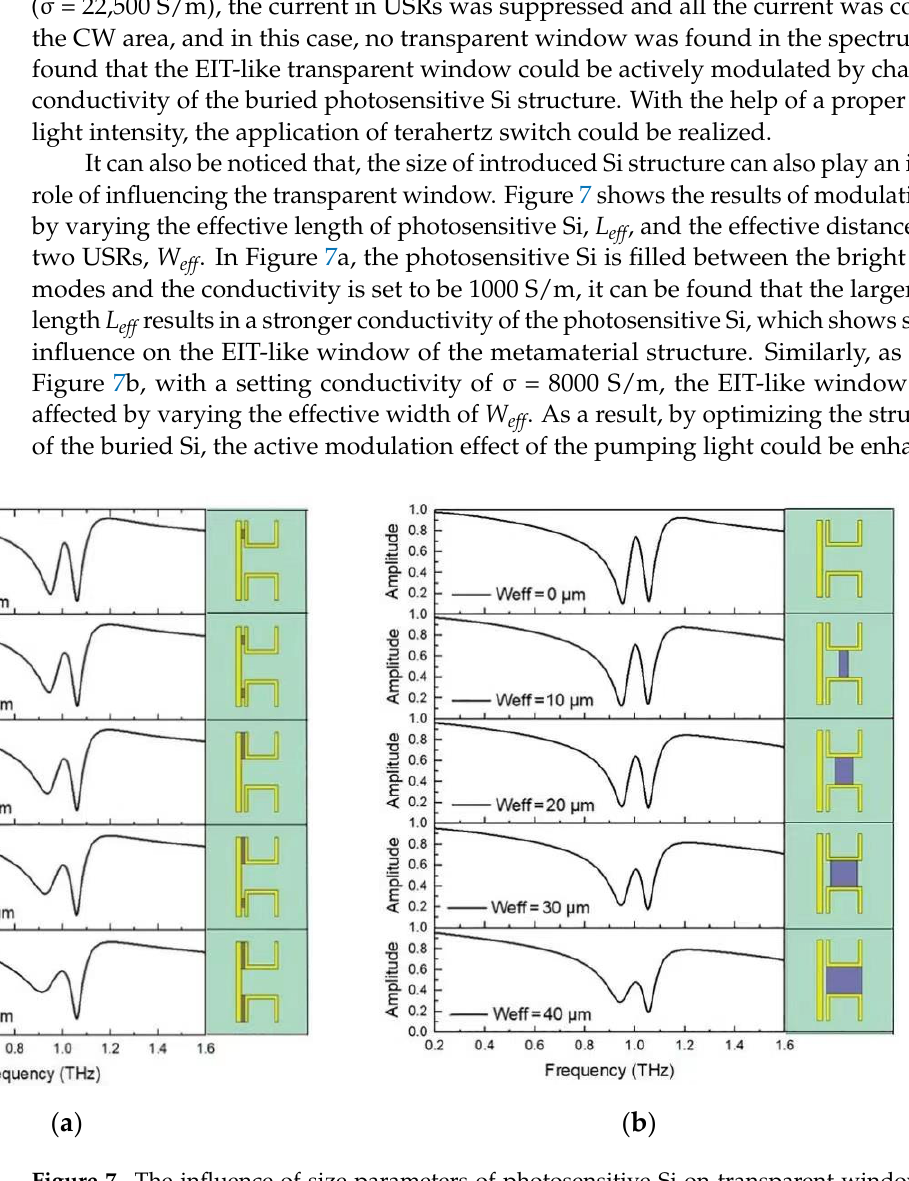
Figure 7. The influence of size parameters of photosensitive Si on transparent window. ( a ) The modulation effect of different effective length L eff of photosensitive Si. As the L eff is larger, the more obvious influence on the EIT-like window of the metamaterials; ( b ) The modulation effect of photosensitive Si with different effective width W eff . With the increase of W eff , the influence on the EIT-like window is greater.